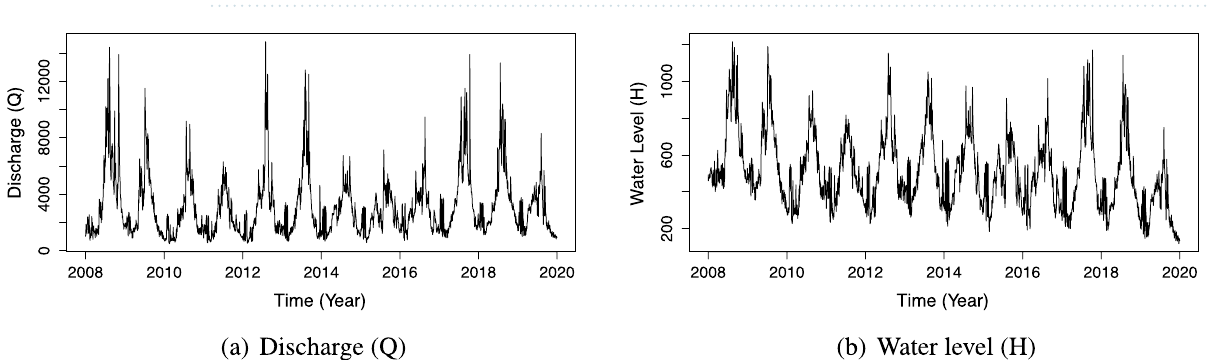
Figure 6. Pirate plot for monthly Discharge and water level of Kon Tum dataset. The mean is relatively small, but the variance is large.